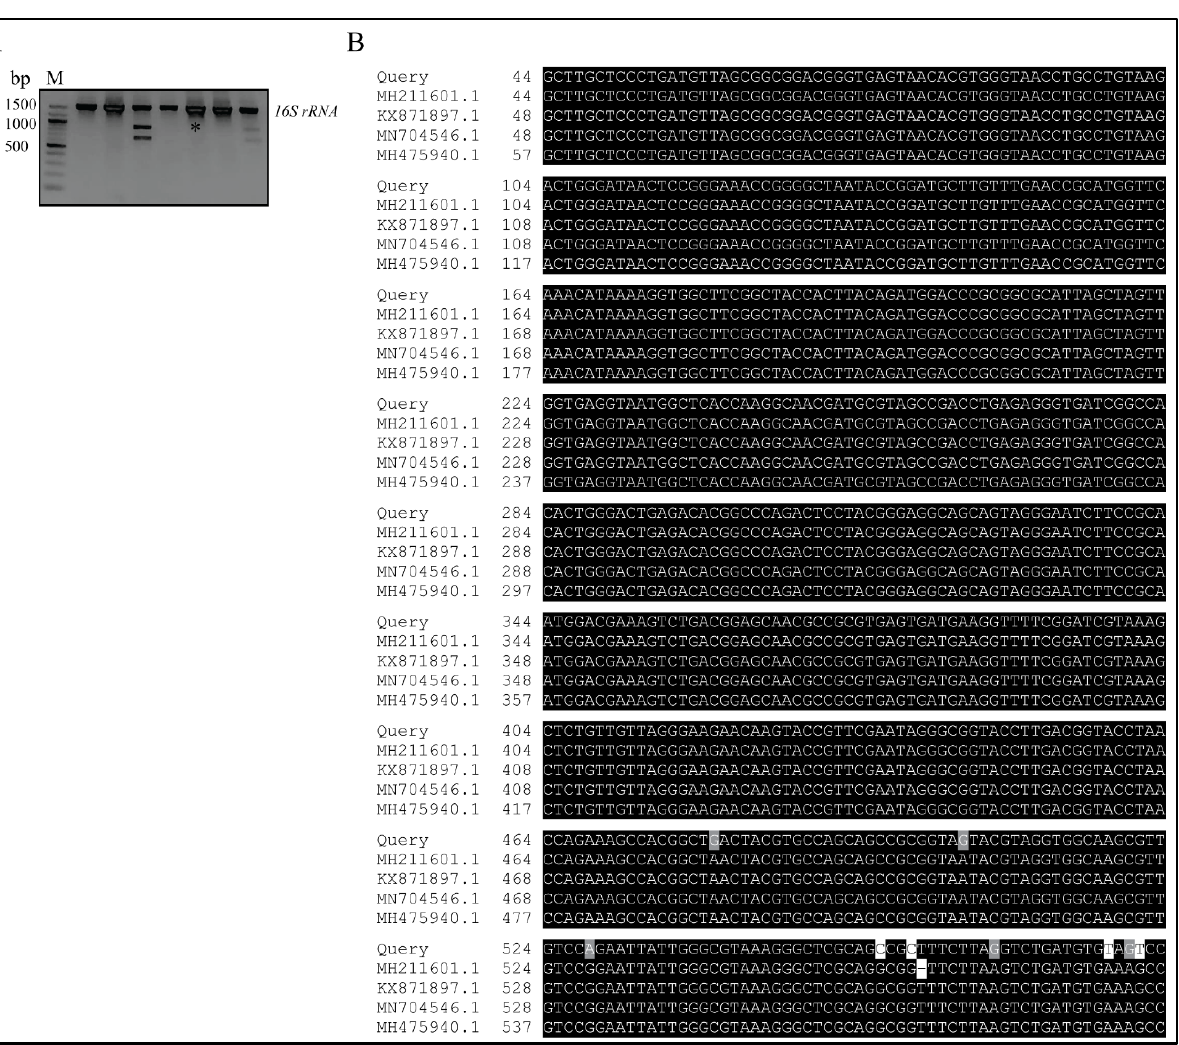
Figure 2. Molecular characterization and phylogenetic analysis of the antibiotic-producing strain BS-40. ( A ) Electrophoretic graph of PCR products on a 1.5% agarose gel stained with ethidium bromide for the 16S rRNA gene among seven soil bacterial isolates; positive isolates yielded a single band of 1500 bp. * refers to BS-40. ( B ) Multiple sequence alignment of one category of the identified 16S rRNA gene of isolate BS-40 (Query) with the related sequences of 16S rRNA genes from bacterial species identified from a BLASTN search of GenBank that exhibited high homology to the queried sequence. The available sequences are aligned via ClustalW, and BOXSHADE was used to highlight the multiple alignment. Black shading indicates that the residue is identical to the column consensus; gray shading indicates that the residue is not identical but at least similar to the column consensus; and no shading indicates that the residue is neither identical nor similar to the consensus.